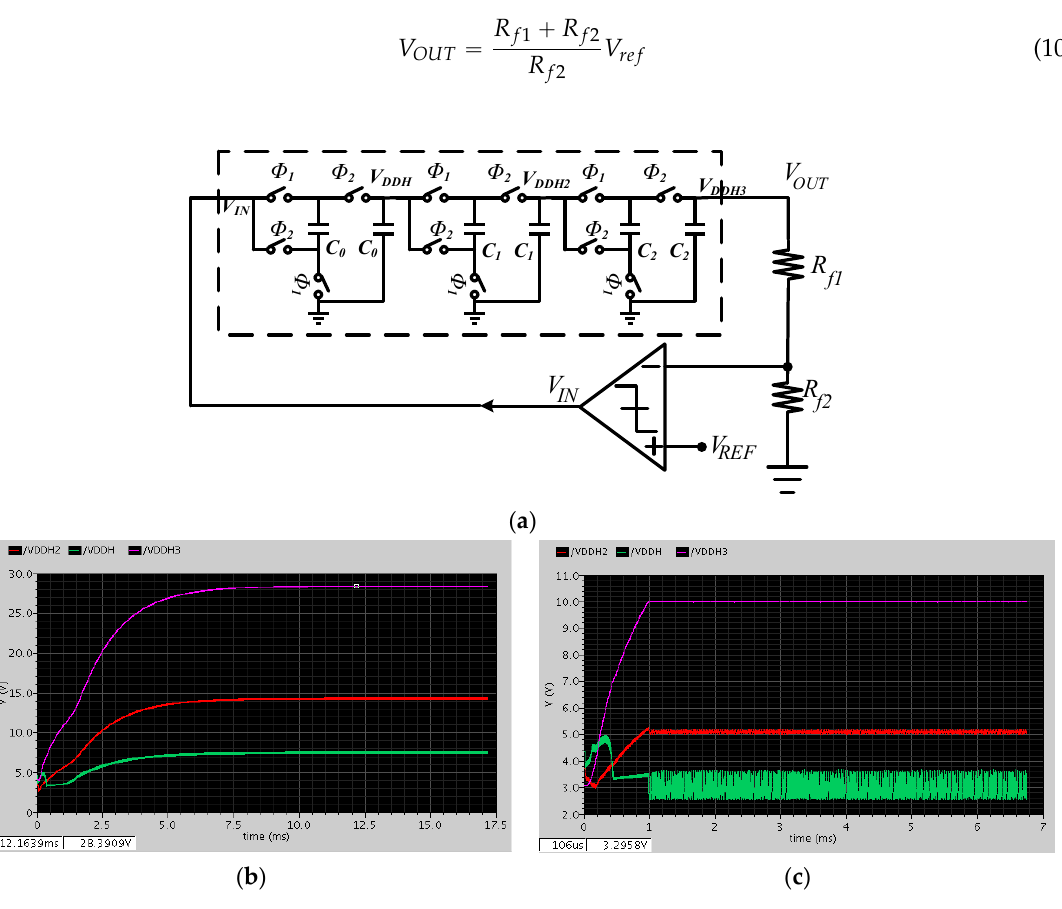
Figure 6. Charge pump: ( a ) Charge pump system with feedback control module; ( b ) Output of cascade charge pump (simulation); ( c ) Output of charge pump system with control module (simulation).